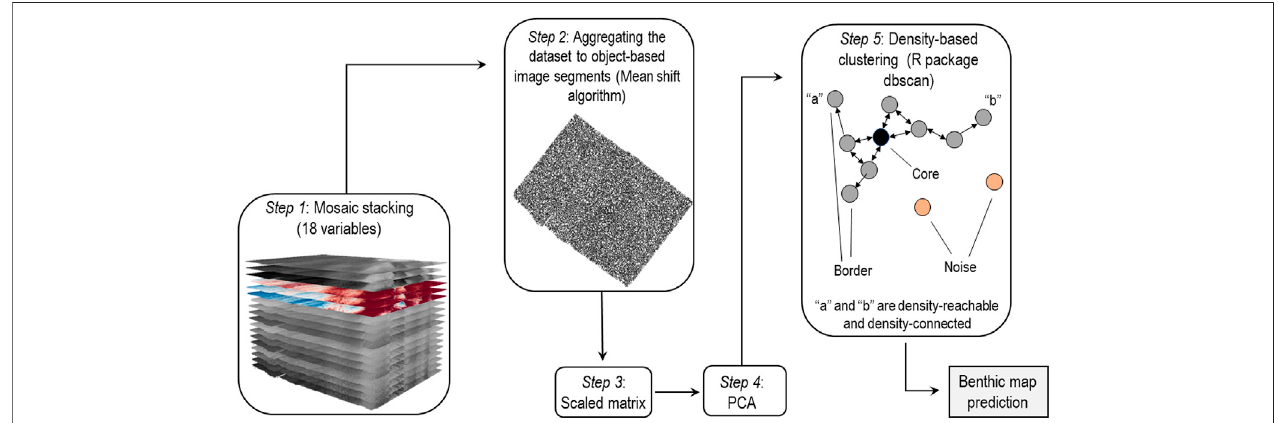
FIGURE3| Work fl owfordensity-basedclusteringofthehighlydimensionalmulti-methodbackscatteranalysis.Illustrativeschemeofdensity-basedclusteringwas adapted from Hahsler et al. (2019).